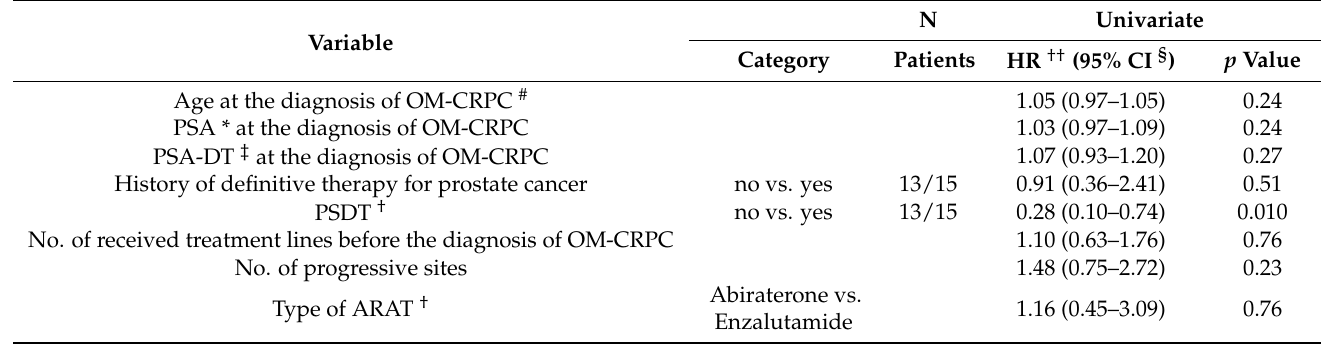
Figure 2. PSA progression-free survival (PSA-PFS) from the start of androgen receptor axis-targeted (ARAT) drugs in oligometastatic castration-resistant prostate cancer patients stratified by performance of progressive site-directed therapy (PSDT). The 95% intervals calculated for each time point are shown as dashed lines. Table 2. Cox hazard model to identify factors predictive of time to PSA progression for an androgen receptor-axis-targeted